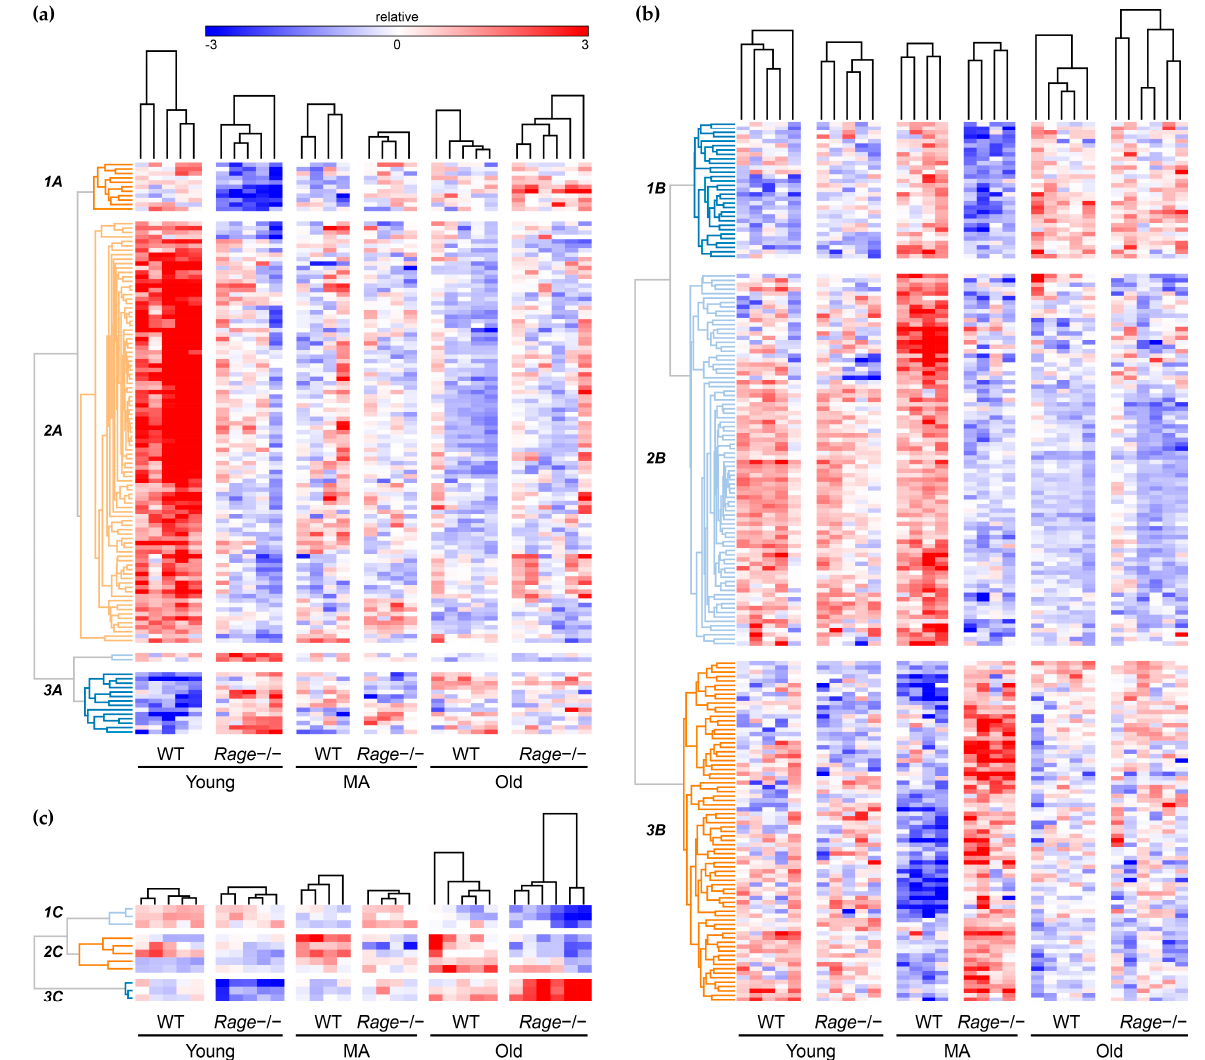
Figure 3. Hierarchical clustering. Hierarchical clustering of differentially expressed genes (DEG) that were identified through the comparisons between Rage − / − and WT in ( a ) Young, ( b ) MA, and ( c ) Old mice. Each heat map includes the expression levels of DEG in one age group and those same genes in the other two age groups. The heat maps show the level of transcripts expression from lower (dark blue) to higher (dark red). Mice (columns) were grouped based on age and genotype. Transcripts (rows) were clustered by applying an unsupervised Pearson’s correlation metric and average linkage method. WT = Wild Type; MA = Middle Age. Young WT n = 5, Young Rage − / − n = 5, MA WT n = 4, MA Rage − / − n = 4, Old WT n = 5, Old Rage − / − n = 6.